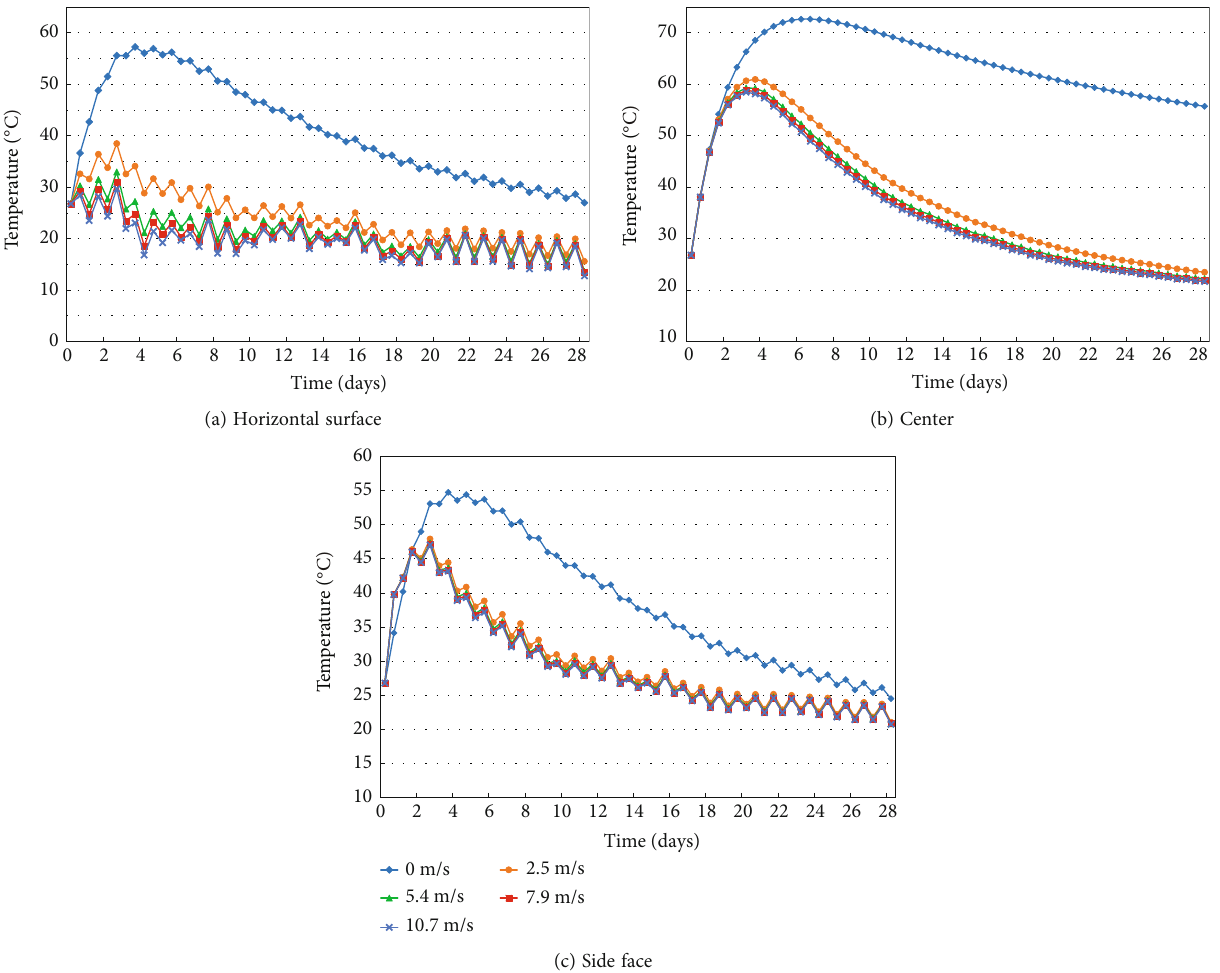
Figure 7: Maximal temperatures of concrete under di ff erent wind